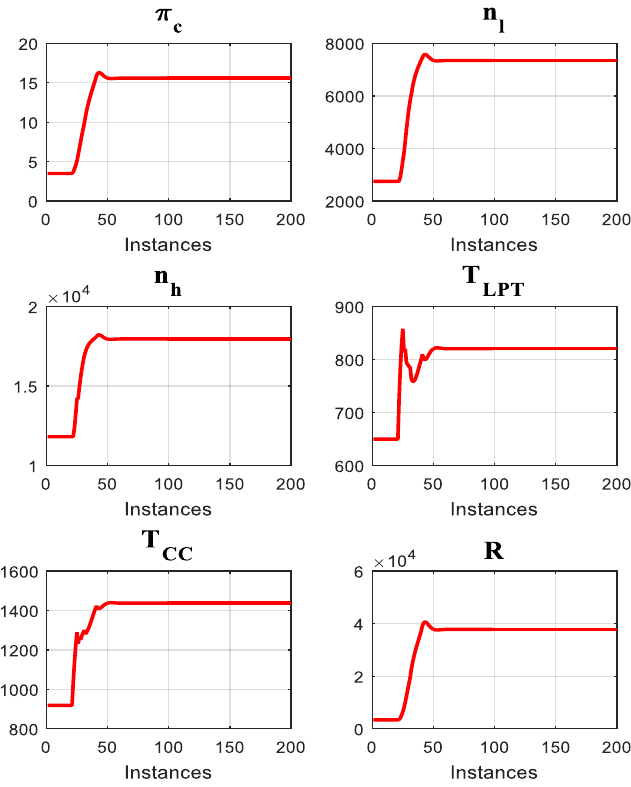
Figure 5. Simulation of dynamic values (hybrid dynamic model).